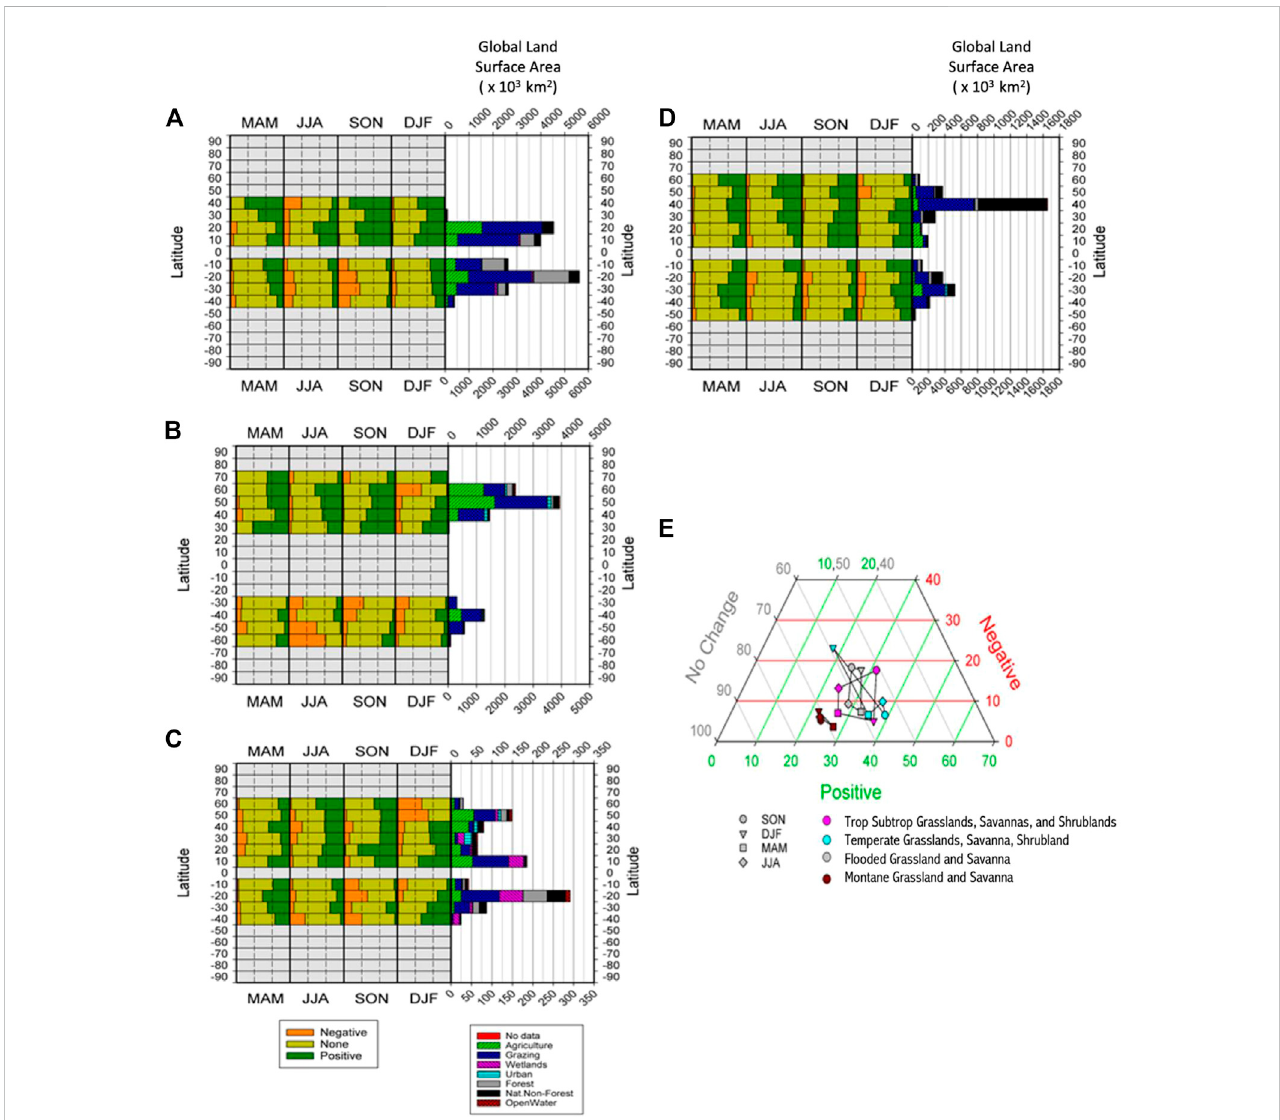
FIGURE 6 Composition of signi fi cant persistence values (Negative, None, Positive) in each biome, broken down by latitudinal band, with land use diversity of each bank also shown, for (A) Tropical and Subtropical grasslands, savannas and shrublands, (B) Temperate grasslands, savannas and shrublands, (C) Flooded grasslands andsavanna, (D) Montanegrasslandandshrublandand (E) Ternaryplotoftheseasonalchangesinpercentagesofglobalareasreturningsigni fi cant percentages of positive and negative persistence, and those reporting to signi fi cant persistence, for four grassland